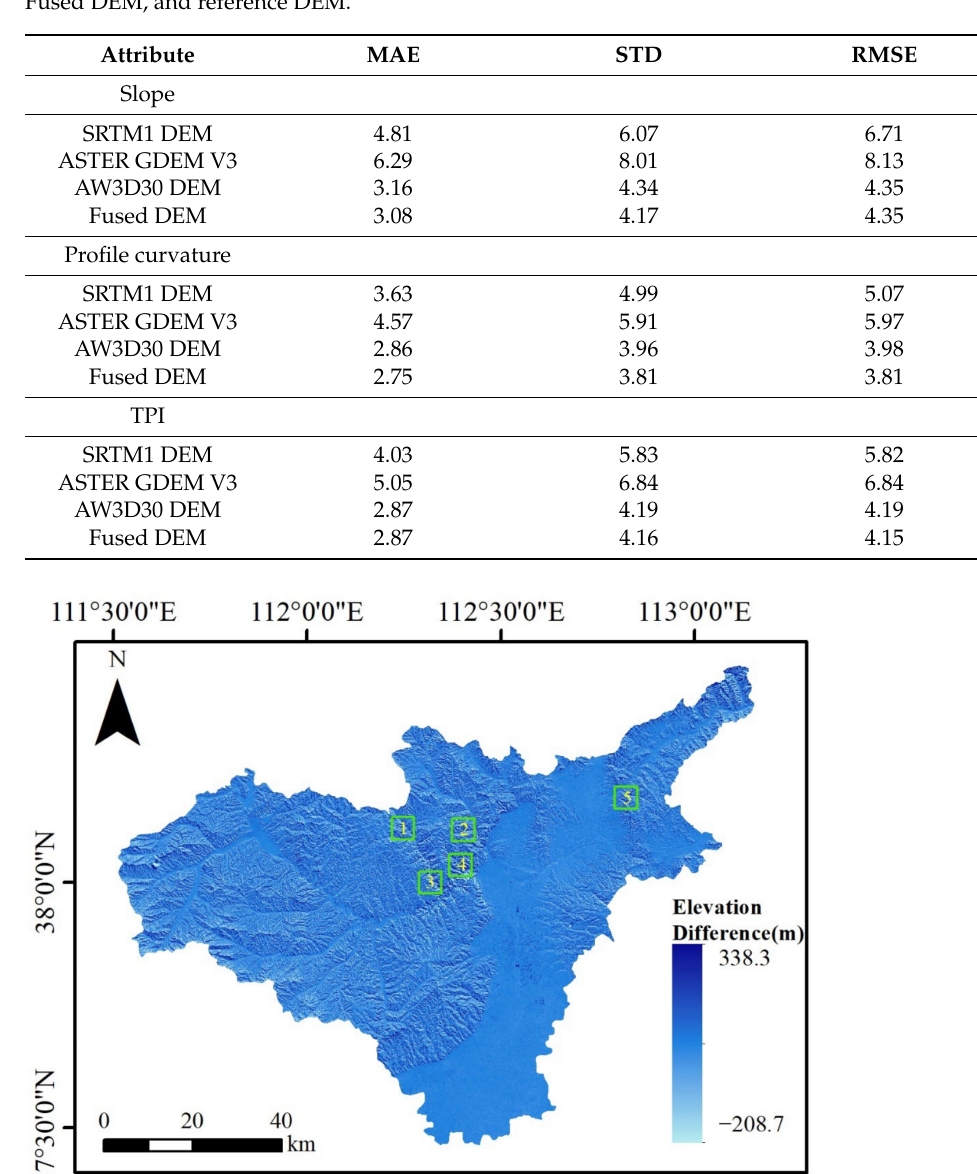
Figure 8. Topographic parameters extracted from the Fused DEM. ( a ) Slope; ( b ) Profile curvature; ( c ) TPI. Table 4. Errors between topographic parameters extracted by SRTM1, ASTER GDEM V3, AW3D30, Fused DEM, and reference DEM.